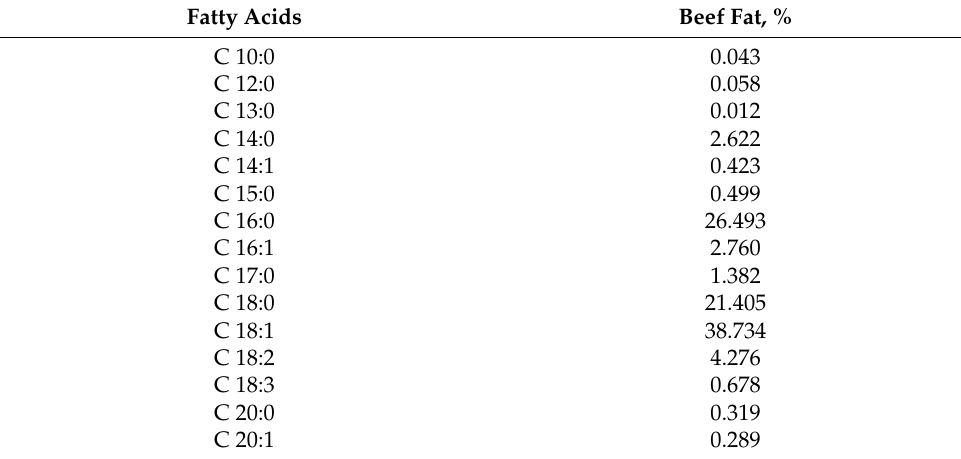
Table 3. The percentage content of fatty acids in the fats under analysis (bovine fat).